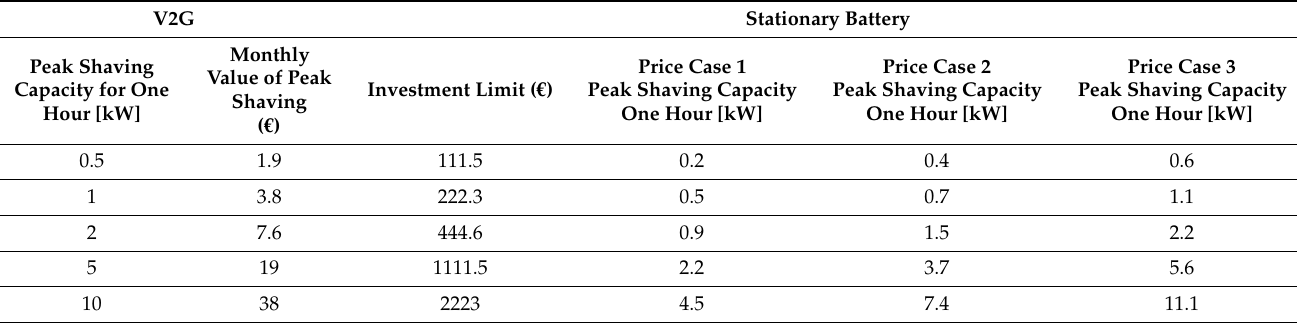
Table 3. Comparison of V2G/B with batteries. A profitable investment in battery is dependent on a low price to achieve the same capacity as V2G/B. Analysis is done based on different prices: € 500 (case 1), € 300 (case 2), € 200 (case